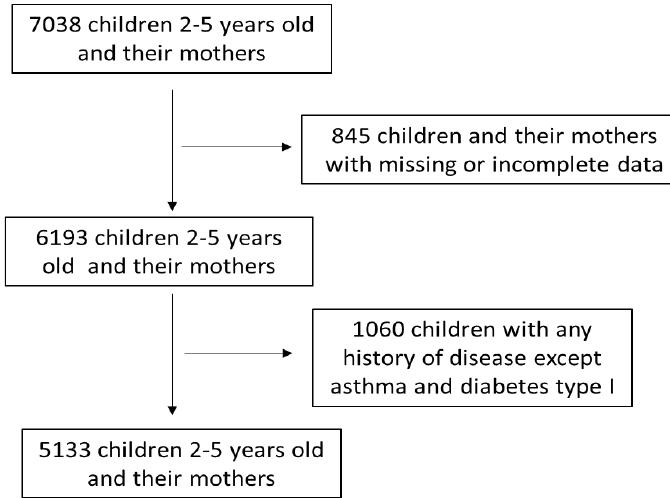
Figure 1. A flow chart of study